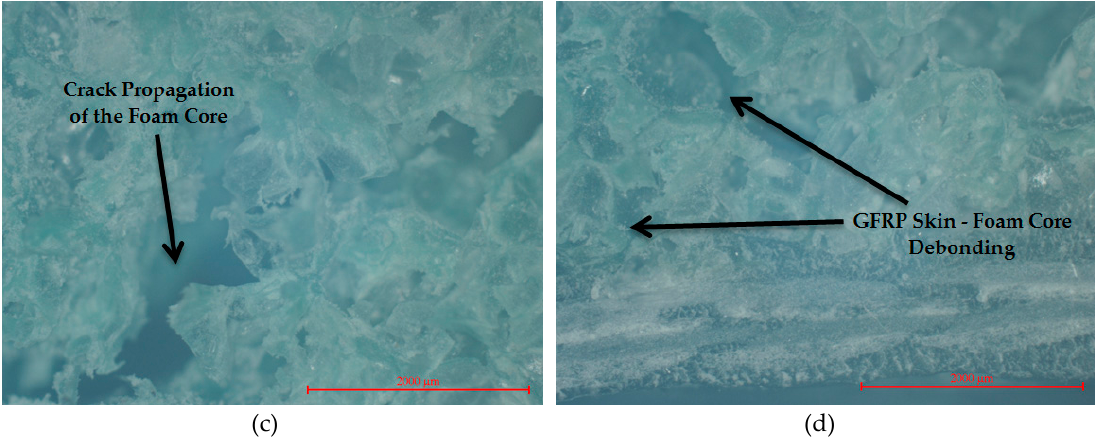
Figure 4. Macroscopic views (magnification 25 × ) of the crack propagation during the three-point bending tests of the ( a ) GFRP-foam specimen; ( b ) Upper GFRP skin-foam core debonding; ( c ) crack propagation of the foam core; ( d ) lower skin-foam core debonding.